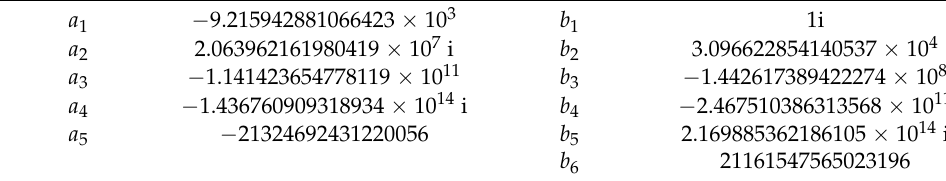
Table A3. Parameters for a forcing amplitude of